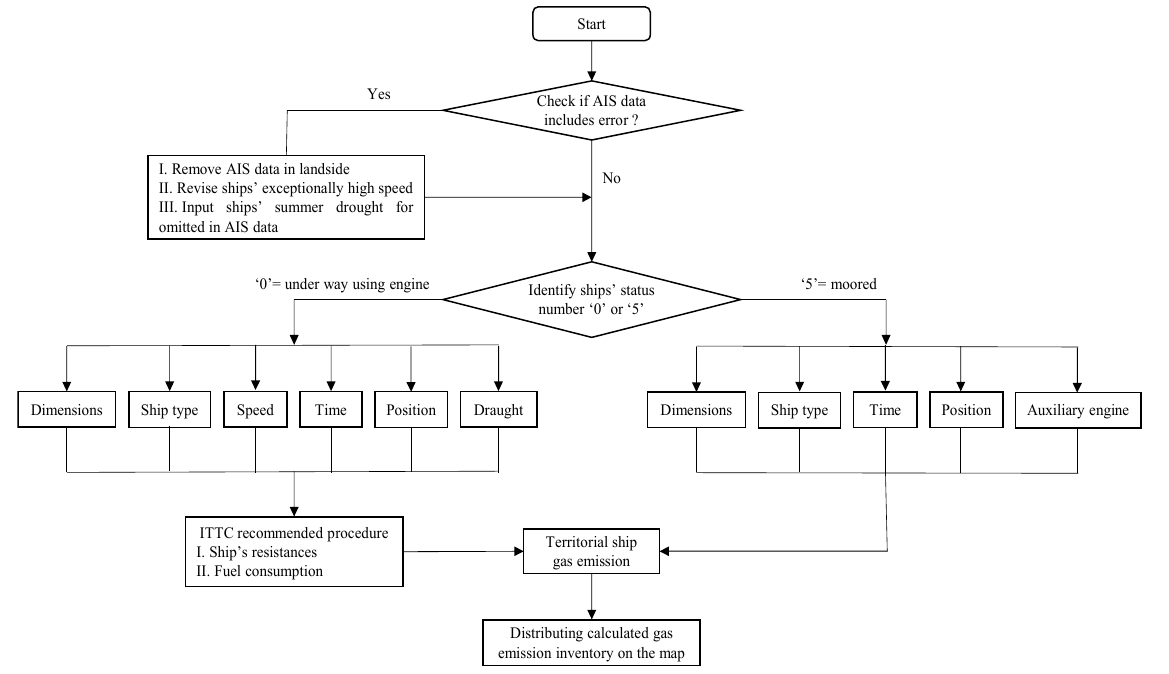
Table 3. SFOC values (g/kW h) of main engines.